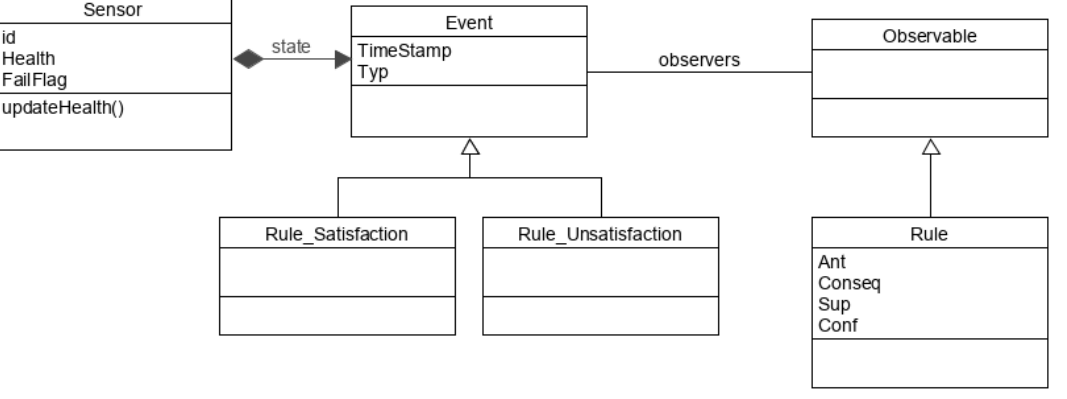
Figure 4. UML analysis object model of the online stage of the failure detection